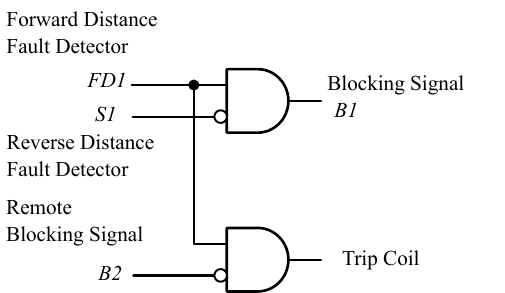
Figure 9. Oneline diagram for a DCB scheme.